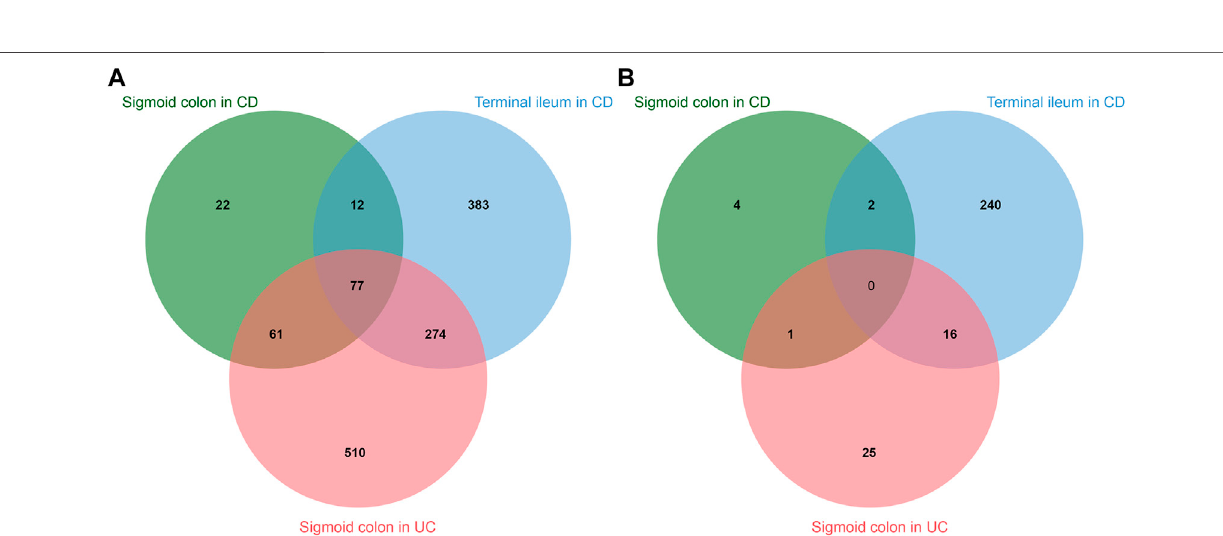
Frontiers in Genetics |